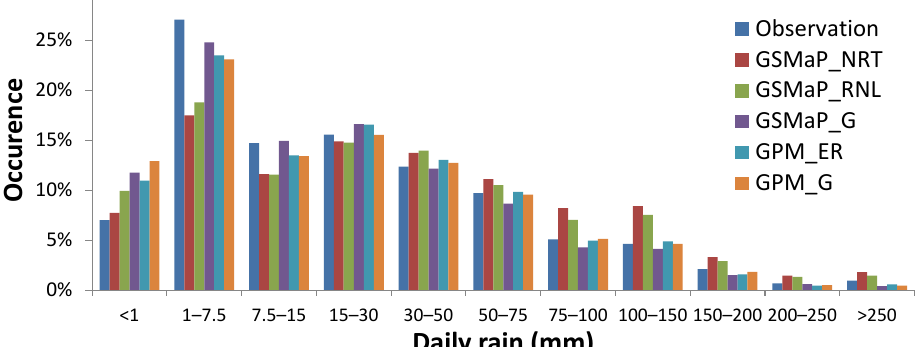
Figure 6. Probability distribution function by frequency of daily mean precipitation induced by